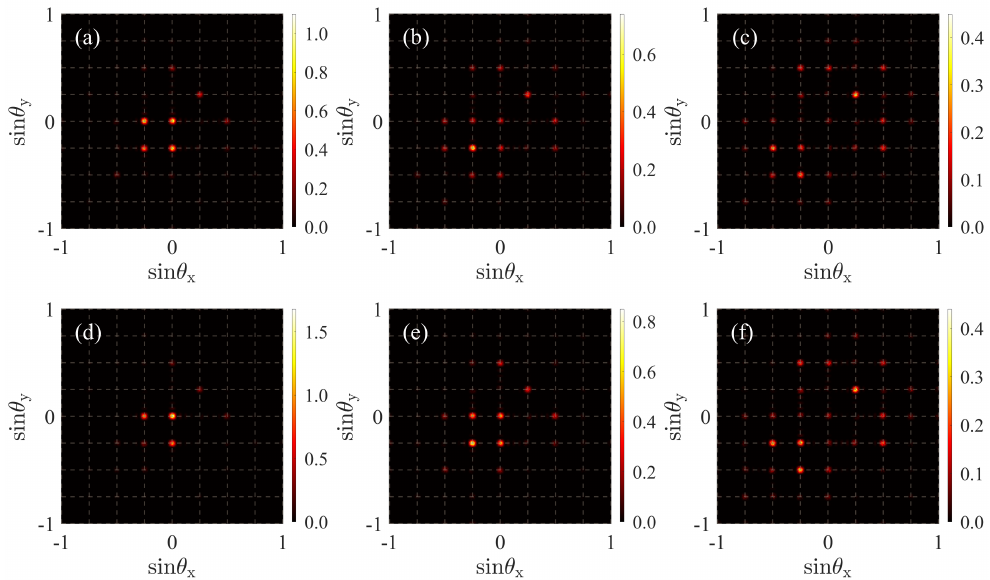
Figure 4. Fraunhofer diffraction intensity 10 I p plotted against sine functions of angles θ x and θ y . The upper panels are attained for L = 200 z 0 with ( a ) δ ∆ c = 1.5 Γ eg ; ( b ) δ ∆ c = 3.0 Γ eg ; ( c ) δ ∆ c = 4.5 Γ eg . The lower panels are attained for δ ∆ c = 2.0 Γ eg with ( d ) L = 100 z 0 ; ( e ) L = 200 z 0 ; ( f ) L = 400 z 0 . Other parameters are the same as in Figure